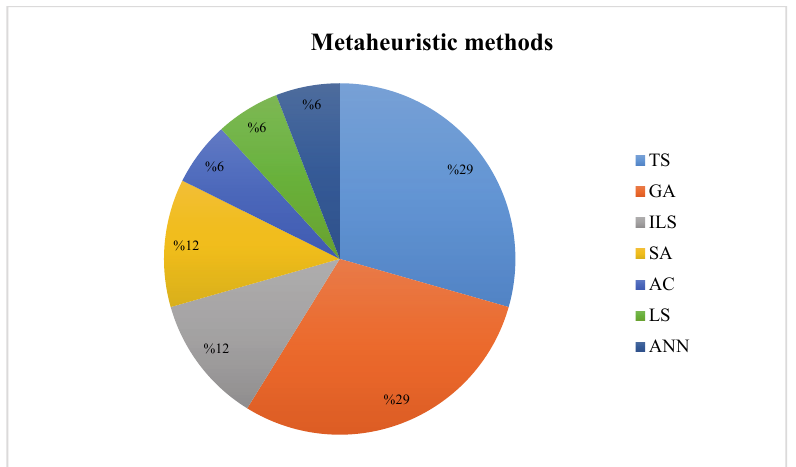
Fig. 9. Distribution of solution metaheuristic